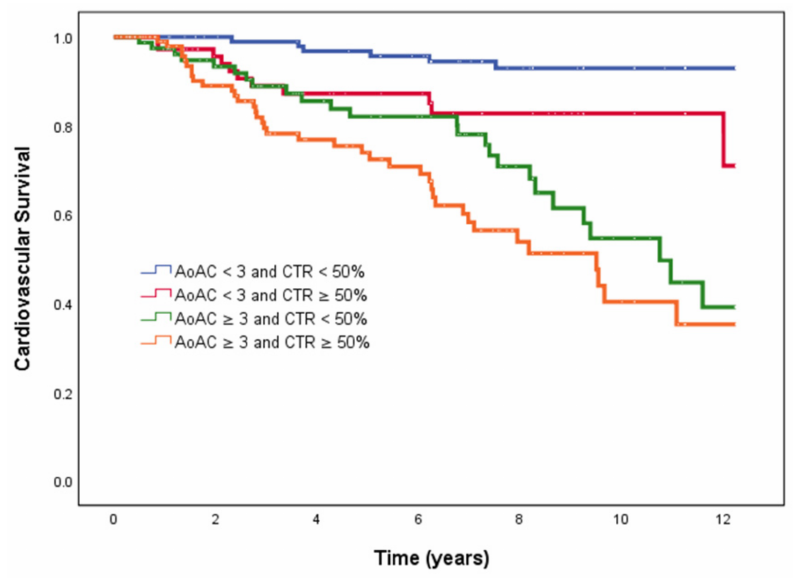
Figure 4. Kaplan–Meier analyses of cardiovascular survival among 4 study groups. The group with AoAC < 3 and CTR ≥ 50%, AoAC ≥ 3 and CTR < 50% and AoAC ≥ 3 and CTR ≥ 50%had worse cardiovascular survival than that with AoAC < 3 and CTR < 50%.